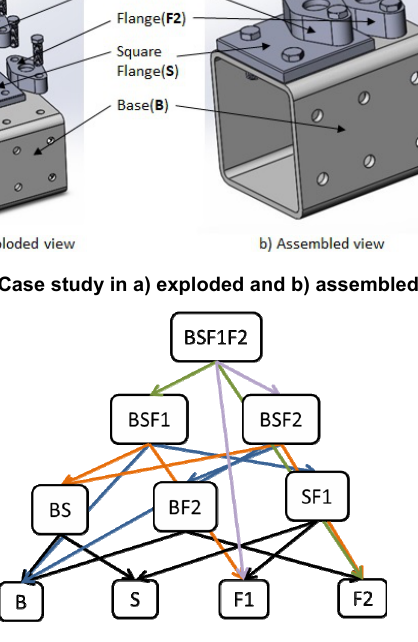
Figure 5. Assembly tree of the case study